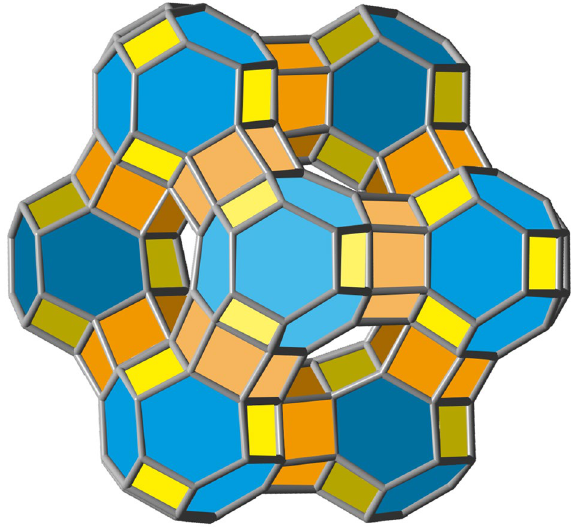
Figure 14. Solid view perspective of a section of the regular skew apeirohedron allotrope of carbon formed by fusions of nuggets 24a through their hexagonal faces via hexagonal prisms. In this figure, there are 10 fused nuggets 24a with 240 carbon atoms.